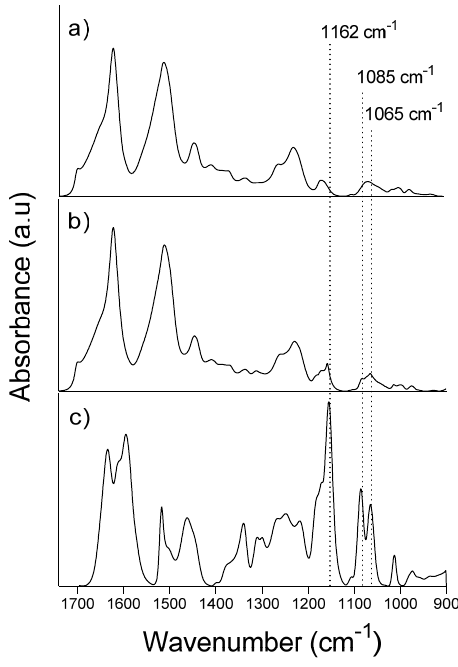
Figure 2. Infrared spectra of virgin SFNs ( a ), NAR-SFNs 1:1 ( b ) and NAR ( c ).